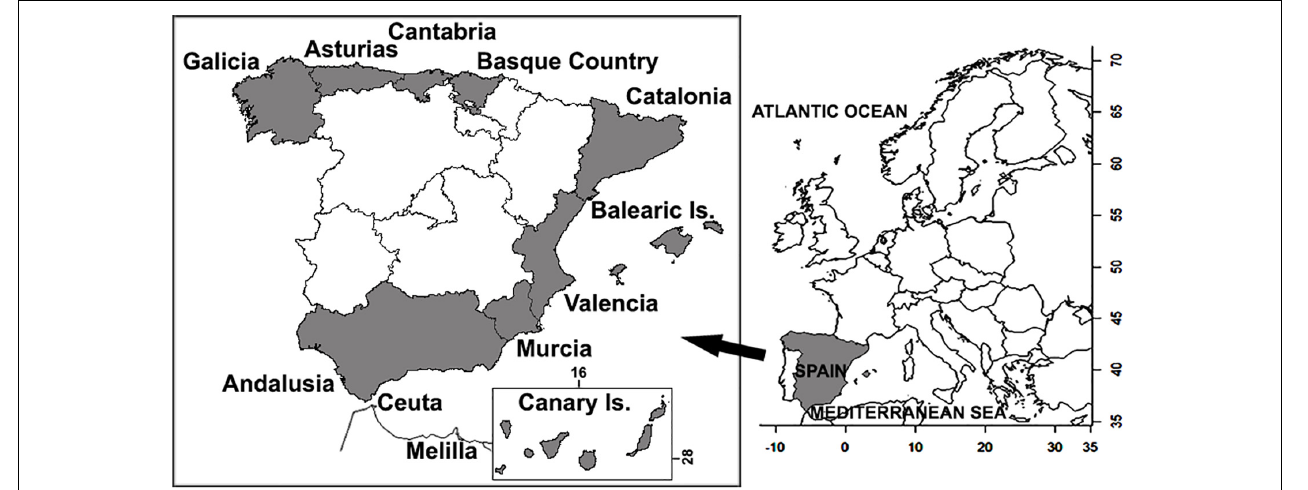
FIGURE 1 | Map of Spain with coastal regions highlighted in